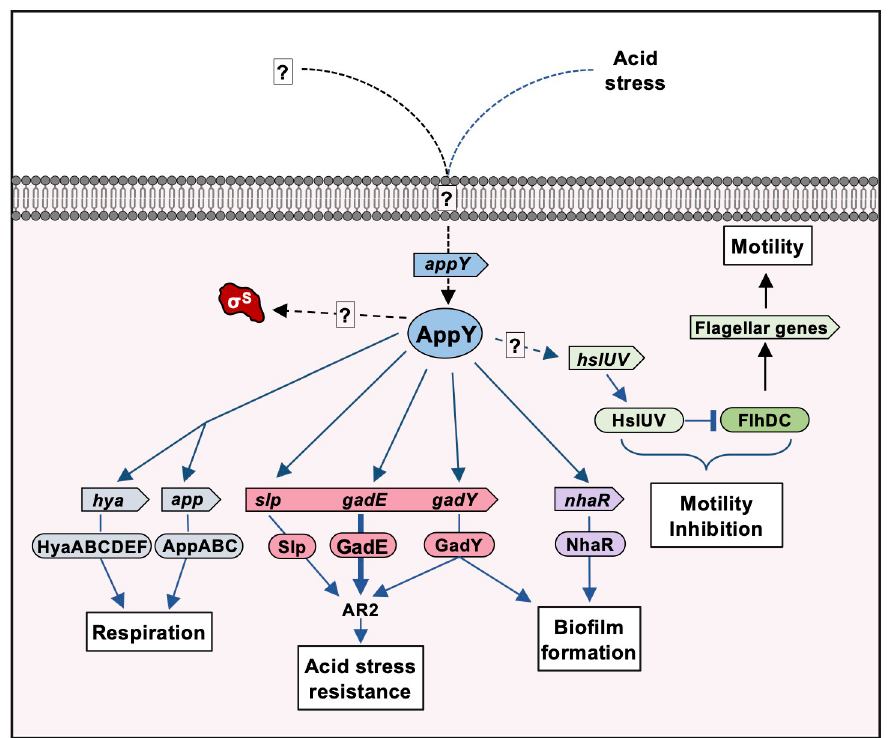
Fig 7. Pleiotropic effects of AppY on E . coli physiology. AppY activates several regulatory cascades leading to acid stress resistance, biofilm formation and motility inhibition. AppY also directly activates the expression of two operons involved in respiration but the consequences of these regulations on host physiology still have to be clarified. appY expression is induced by acid stress and probably by other environmental signals. AppY also leads to the stabilization of the sigma factor RpoS by an unknown mechanism. Under certain conditions, RpoS contributes to the expression of several genes under AppY control. The black arrows indicate the already known regulations, the blue arrows the regulations defined in this work and the dashed arrows regulations for which the molecular mechanism is not